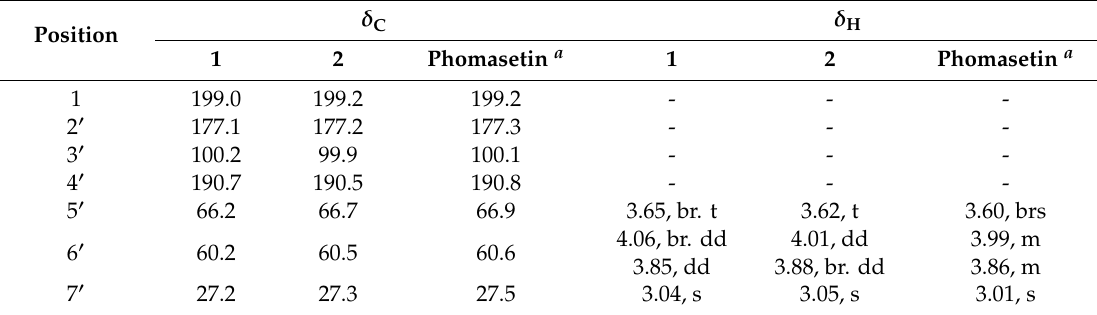
Table 2. Comparison of the NMR data (CDCl 3 ) for the tetramic acid moiety.